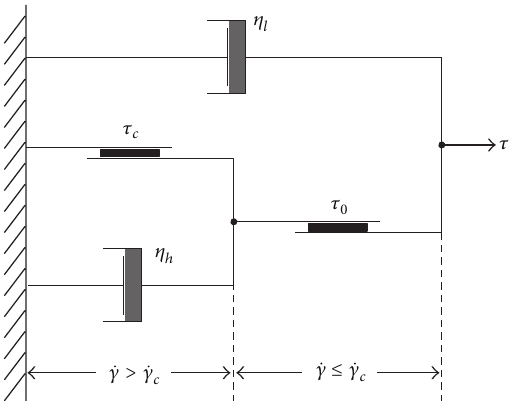
Figure 4: Schematic diagram of improved bilinear fluid model.